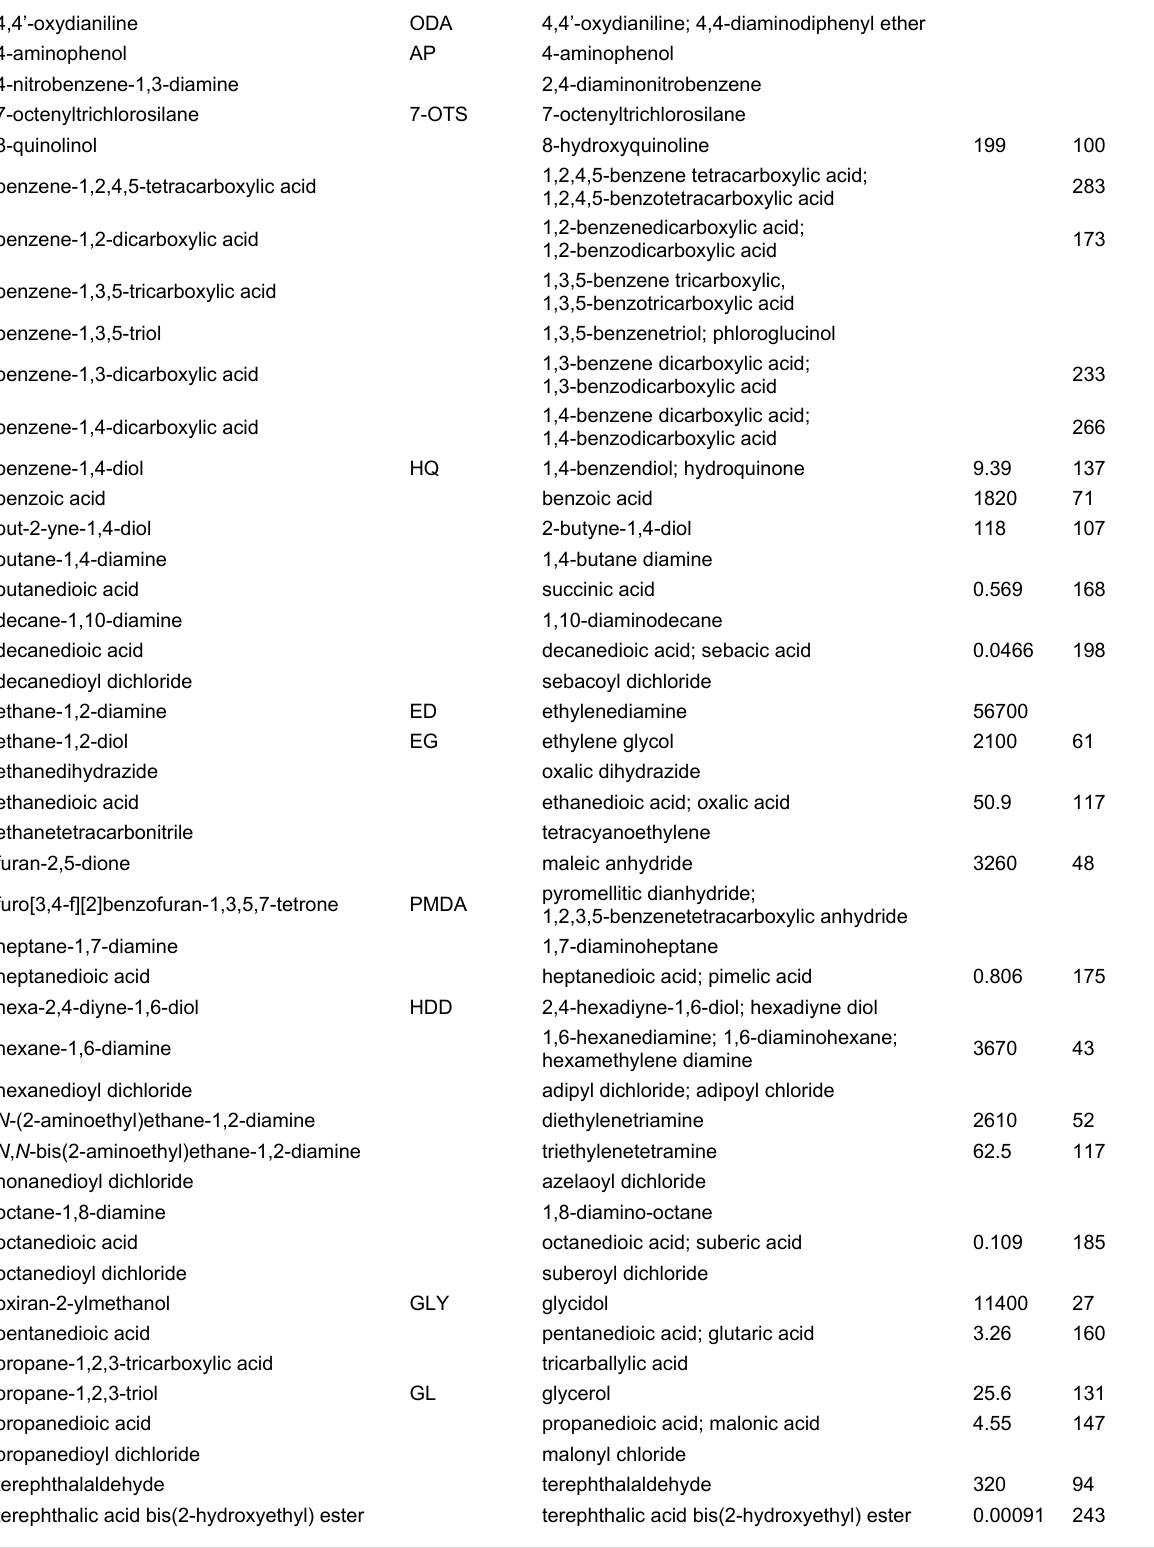
Table 1: Organic compounds (and their different names and abbreviations) employed in MLD and ALD/MLD processes together with vapor pres- sures, P , at 100 °C and temperatures, T , corresponding to a vapor pressure of 2 mbar for some of the organic precursors (the values were calculated by using the equations and parameters obtained from the DIPPR Project 801 database (full version) [58]).